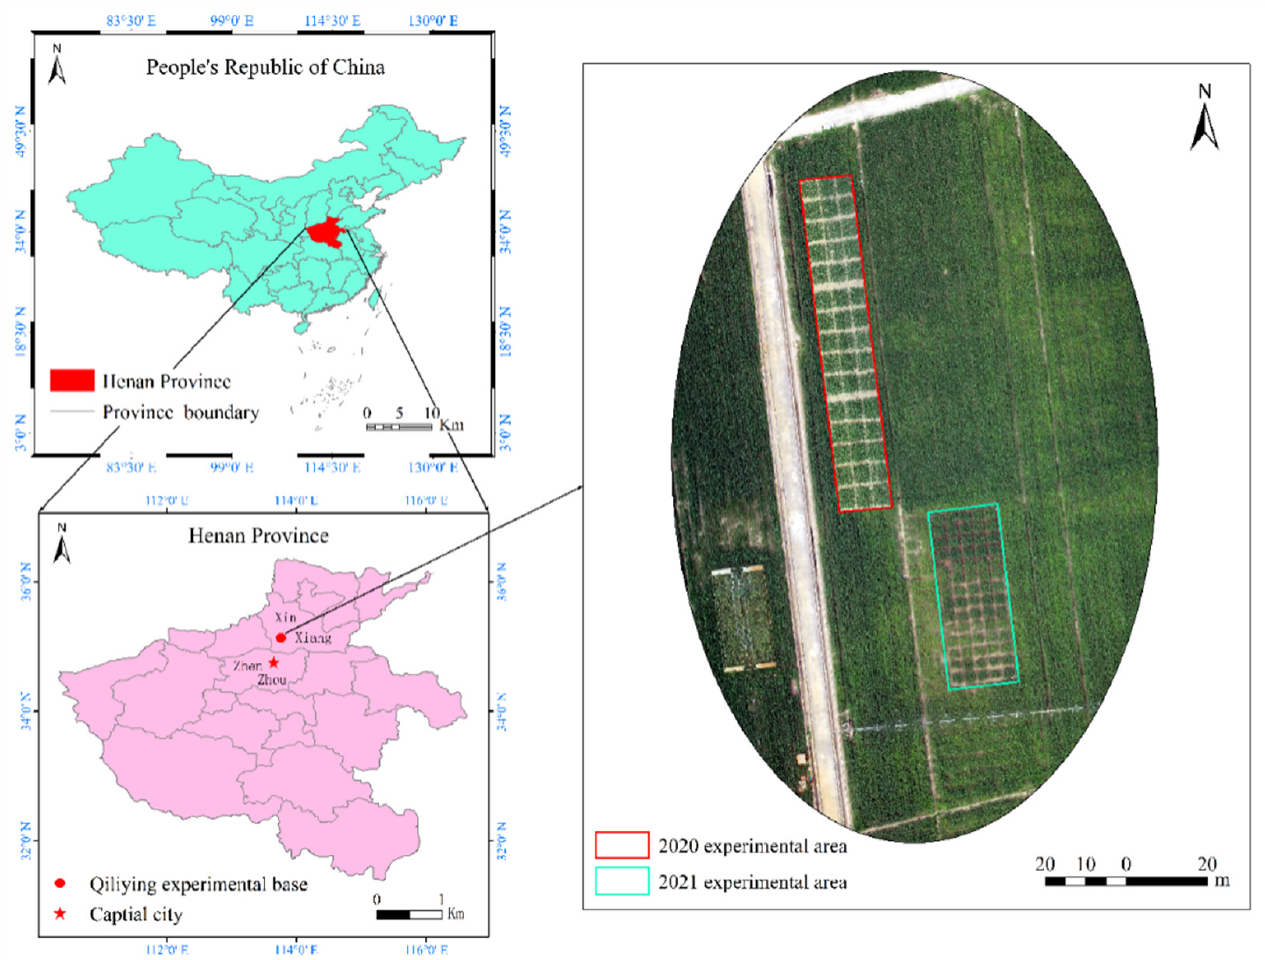
Figure 1. Geographic location of the study area.